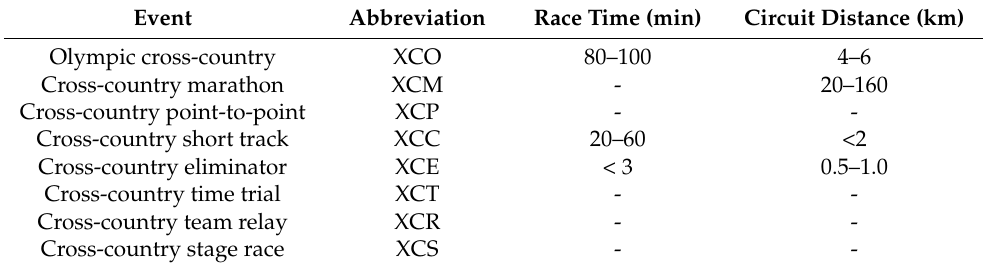
Table 1. Types of cross-country mountain biking